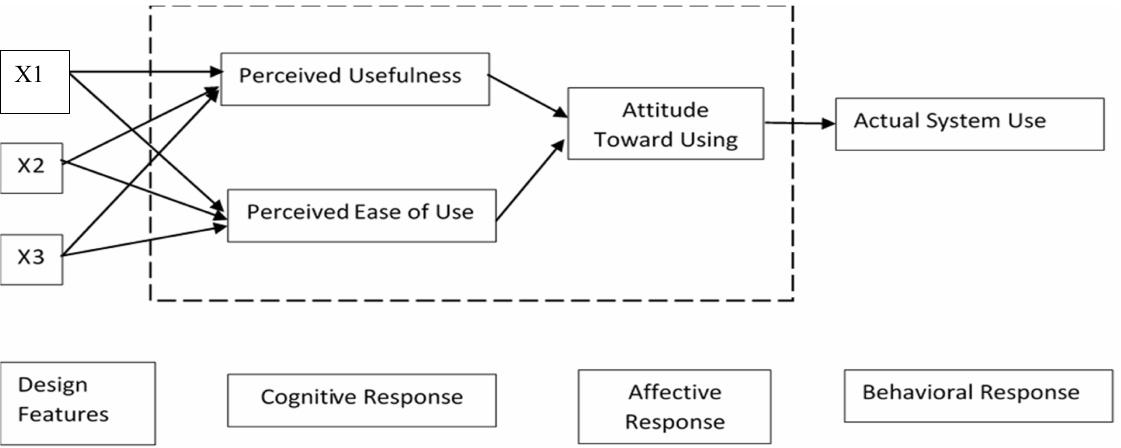
Fig. 1 Technology Acceptance Model (TAM) “original version” proposed by [22]